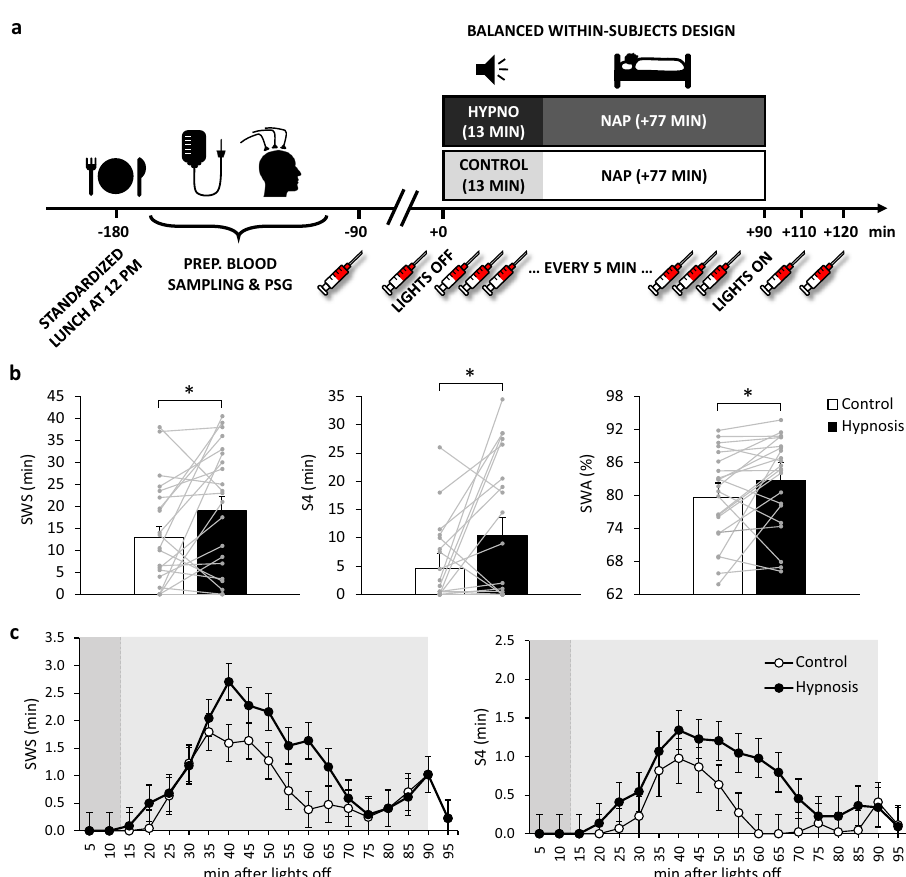
Fig. 1 Study design and effects of hypnotic suggestions on slow-wave sleep (SWS). a The experimental sessions started with a standardized lunch at 12 p.m., following which the participants received an intravenous catheter for repeated blood sampling and were prepared for polysomnographic recordings. After lights were turned off for a 90-min nap, the presentation of a 13-min audio tape that included either hypnotic suggestions to sleep deeper (Hypnosis condition) or a neutral control text (Control condition) started. Participants were allowed to fall asleep during presentation of the audio tape and were awakened 77 min after the end of the tape (summing up to a total of 90 min of sleep opportunity). Blood was collected ~90 min and immediately before turning lights off, then every 5 min for 90 min, and 10 and 20 min after turning lights on. Blood was sampled via the intravenous catheter, which was connected to a long tube that enabled blood collection from an adjacent room to avoid disturbing the participants ’ sleep. PSG polysomnography. b Means (±SEM) of time spent in SWS (left) and sleep stage S4 (middle), and relative slow-wave activity (SWA; right) after listening to hypnotic suggestions (black bars) vs. a neutral control text (white bars). c Estimated marginal means (±SEM) of minutes spent in SWS and S4 per 5-min bin. Light gray area indicates nap time, darker gray area within nap time indicates duration of the audio tape. * p < 0.05 for two-sided paired t -tests; see Table 2 for results of linear mixed models analyses; n =